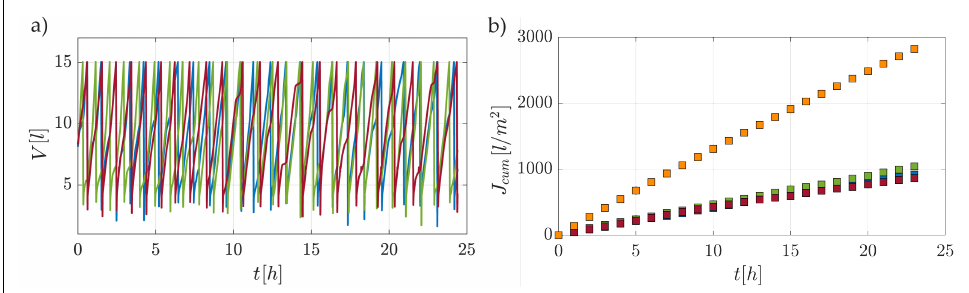
Figure 4. Results of S-4_1.5 filtration test with a feed pressure of 1.5 bar; ( a ) fill levels of the three filtrate collection tanks vs. time; ( b ) total water flux and flux measured from the individual portions. In both panels, blue, green and red lines/symbols refer to, up, mid and down collection tanks, respectively (see Figure 1). Orange squares in panel ( b ) refer to the cumulative